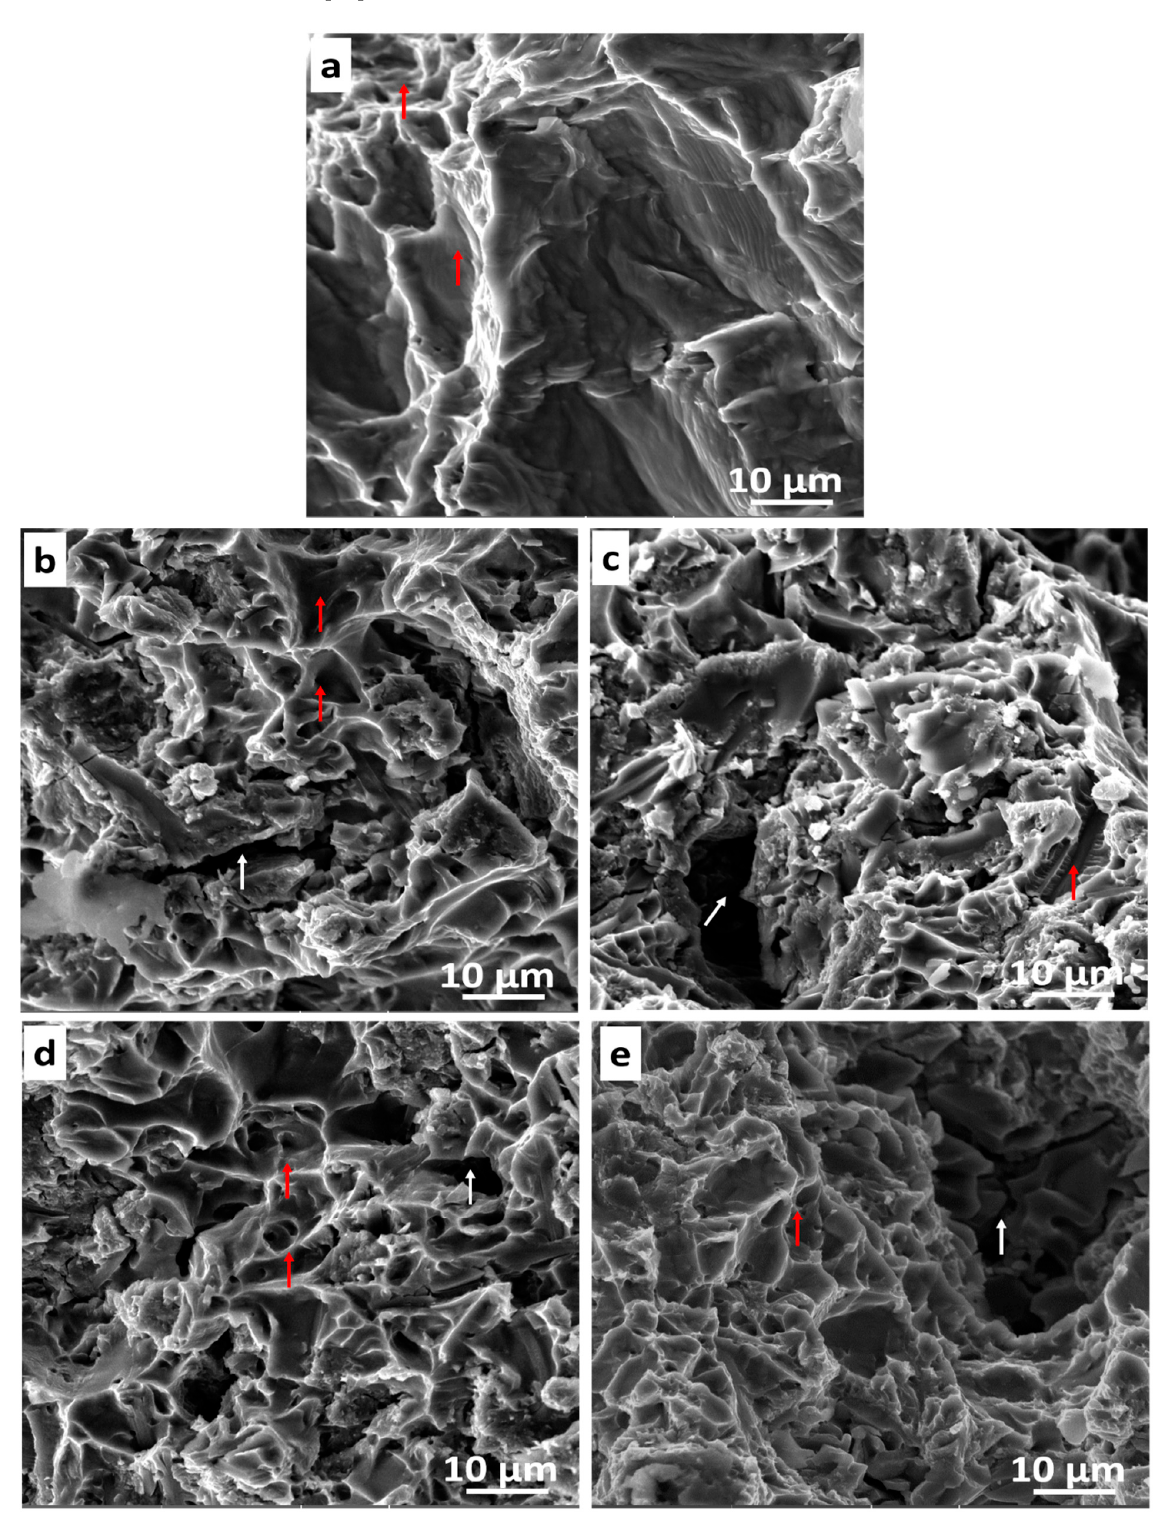
Figure 19. The micrographs of the fractured surfaces of the sintered samples ( a ) T0.0, ( b ) T2.5, ( c ) T5.0, ( d ) T7.5, and ( e ) T10.